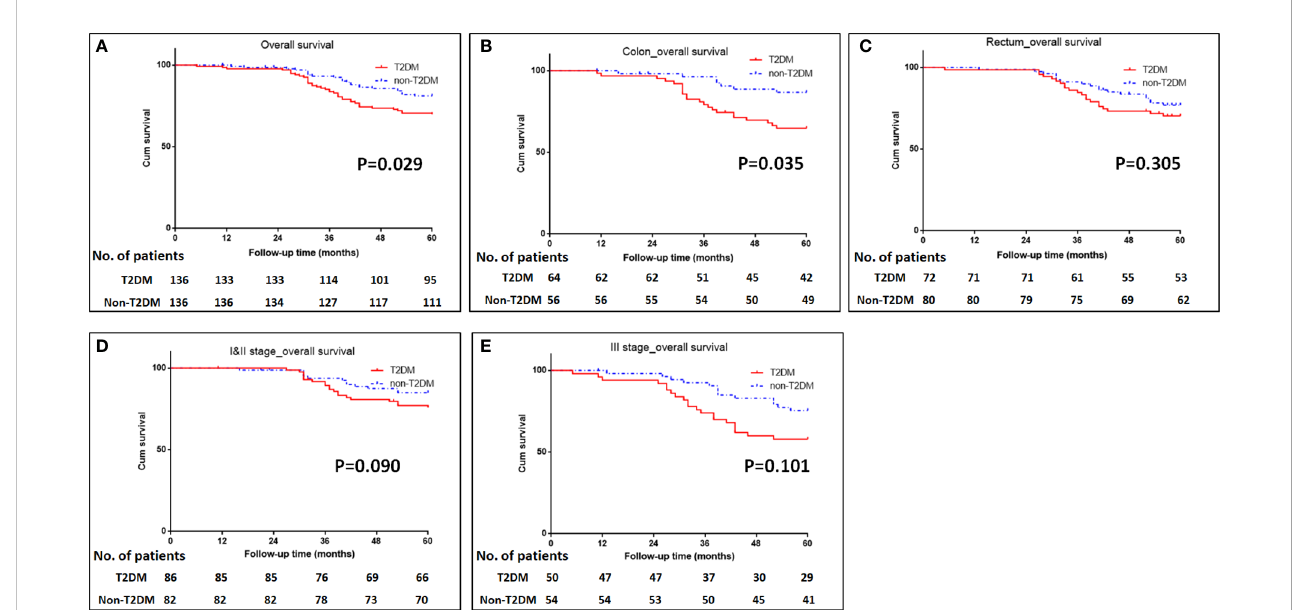
FIGURE 1 Kaplan-Meier analysis of survival in patients with T2DM. (A) Kaplan-Meier analysis of overall survival for all patients. (B, C) Kaplan-Meier analysis of overall survival for patients with colonic cancer (B) or rectal cancer (C) . (D, E) Kaplan-Meier analysis of overall survival for CRC patients with TNM I&II stage (D) or III stage (E)